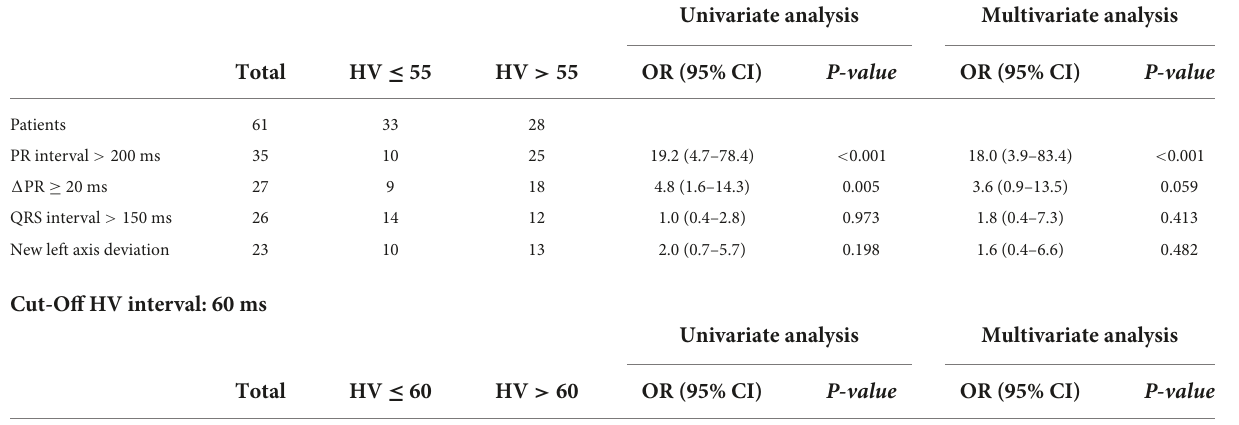
TABLE 3 Prediction of abnormal HV post-implantation based on the electrocardiogram. Cut-Off HV interval: 55 ms